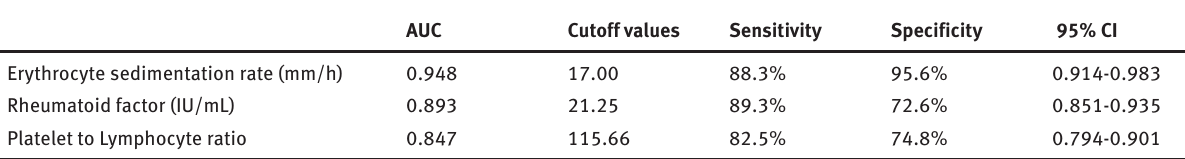
Table 3: The performance of ESR,RF,and PLR for RA